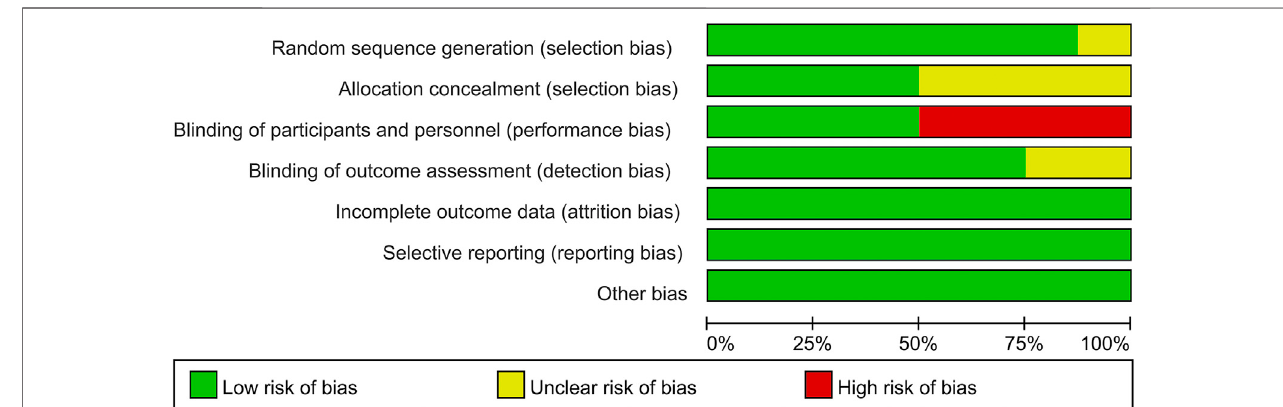
FIGURE 3 | Risk of bias summary: each risk of bias item is presented as the percentage across all the included studies, which indicates the proportion of different levels of risk of bias for each item.